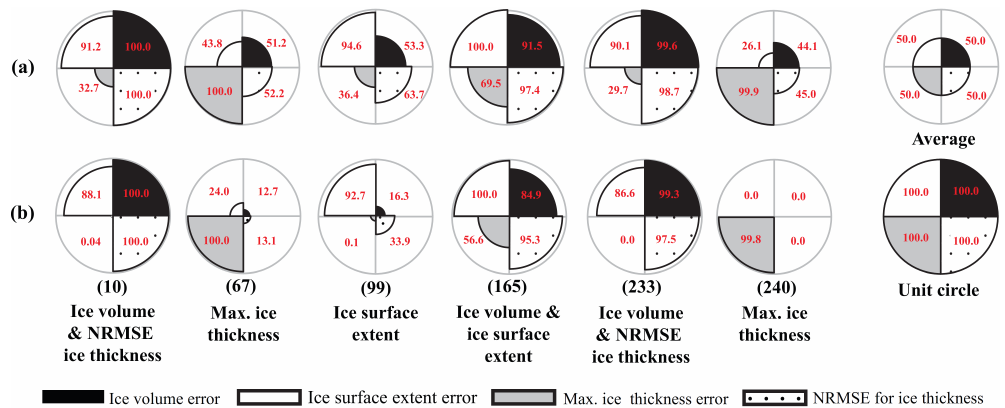
Figure 10. Normalised star plots showing the relative measure of skill for each 2 Fig. 10. Normalised star plots showing the relative measure of skill for each diagnostic. The best skill score corresponds to a radius of 100% as shown by the unit circle. Relative measure of skill for (a) the six selected experiments compared with all 250 LHS experiments and (b) the diagnostic. The best skill score corresponds to a radius of 100 % as shown by the unit 3 final six chosen experiments compared with each other. The numbers below each experiment correspond to the experiment identification number relating to the original 250 LHS experiments. circle. Relative measure of skill for a) the six selected experiments compared with all 4 250 LHS experiments and b) the final six chosen experiments compared with each 5 other. The numbers below each experiment correspond to the experiment 6 identification number relating to the original 250 LHS experiments. 7